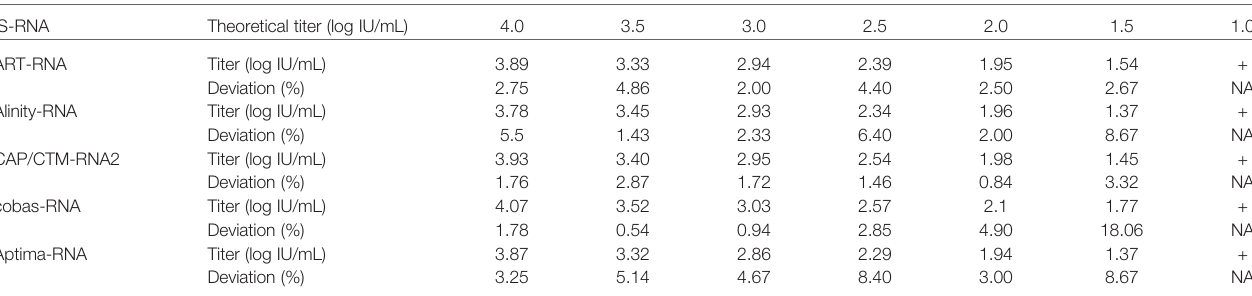
TABLE 4 | Detection of HCV RNA in International Standard by HCV RNA quanti fi cation kits. IS-RNA